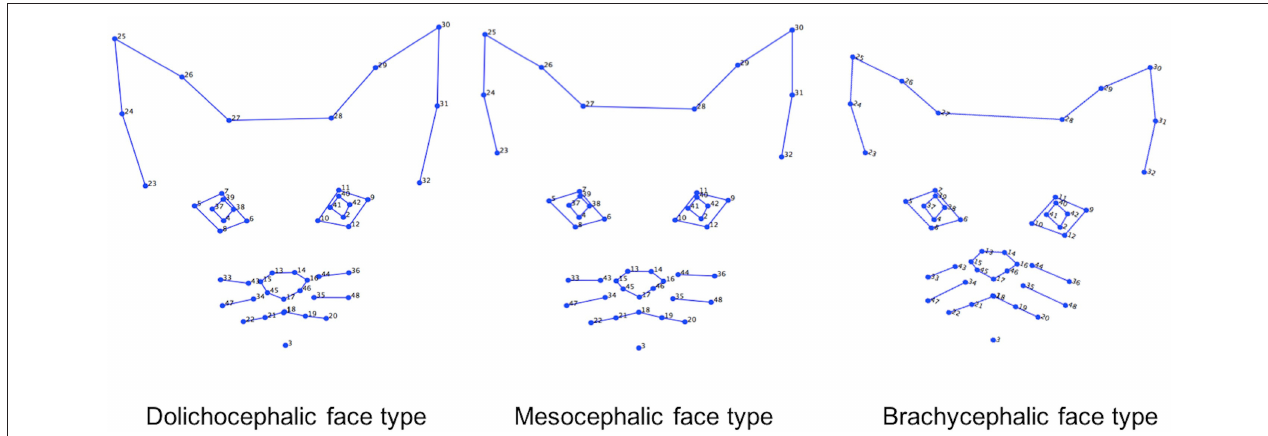
FIGURE 5 | Geometric wireframes created for each of the three main cephalic face types. Wireframes are based on average landmark positions for each cephalic type ( n = 1,888). Wireframes produced using MorphoJ, Version 1.06d (57). = 1.7e-27) and PC4 ( u = 3,310, p = 0.009372), but